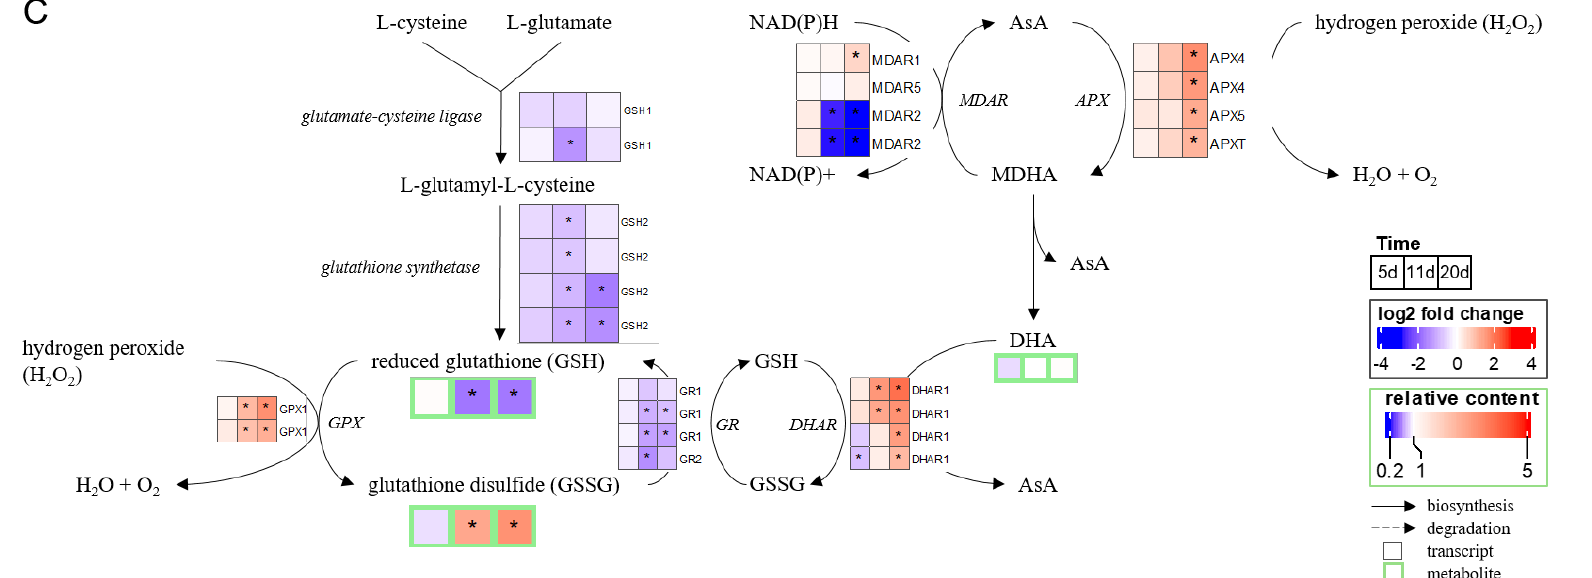
Figure 6. Summary schemes showing the main changes in leaves of B. napus induced by water deficit at the transcriptomic and metabolomics levels relative to control plants. B. napus plants were exposed to water deficit for 5 d (mild), 11 d (severe), and 20 d (severe and extended). Color-filled boxes indicate the log2 fold change of DEGs or the relative content of ABA ( A ), JA ( B ), and reduced and oxidized glutathione ( C ). Up and down modulations are indicated in red and blue, respectively. Significant variations in gene expression or metabolite levels between control and plants exposed to WD are indicated with an asterisk (*) for an adjusted p -value < 0.05. Solid and dashed lines indicate biosynthesis and degradation pathways, respectively. 1 hydroperoxylinolenic acid; 2 12,13(S)-epoxylinolenic acid; 3 2-oxo-phytodienoic acid; 4 oxo-pentenyll-cyclopentane; APX: ascorbate peroxidase; AsA: L-ascorbate; DHA: dehydroascorbic acid; DHAR: dehydroascorbate reductase; GPX: glutathione peroxidase; GR: glutathione reductase; MDAR: monodehydroascorbate reductase; MDHA: monodehydroascorbate.